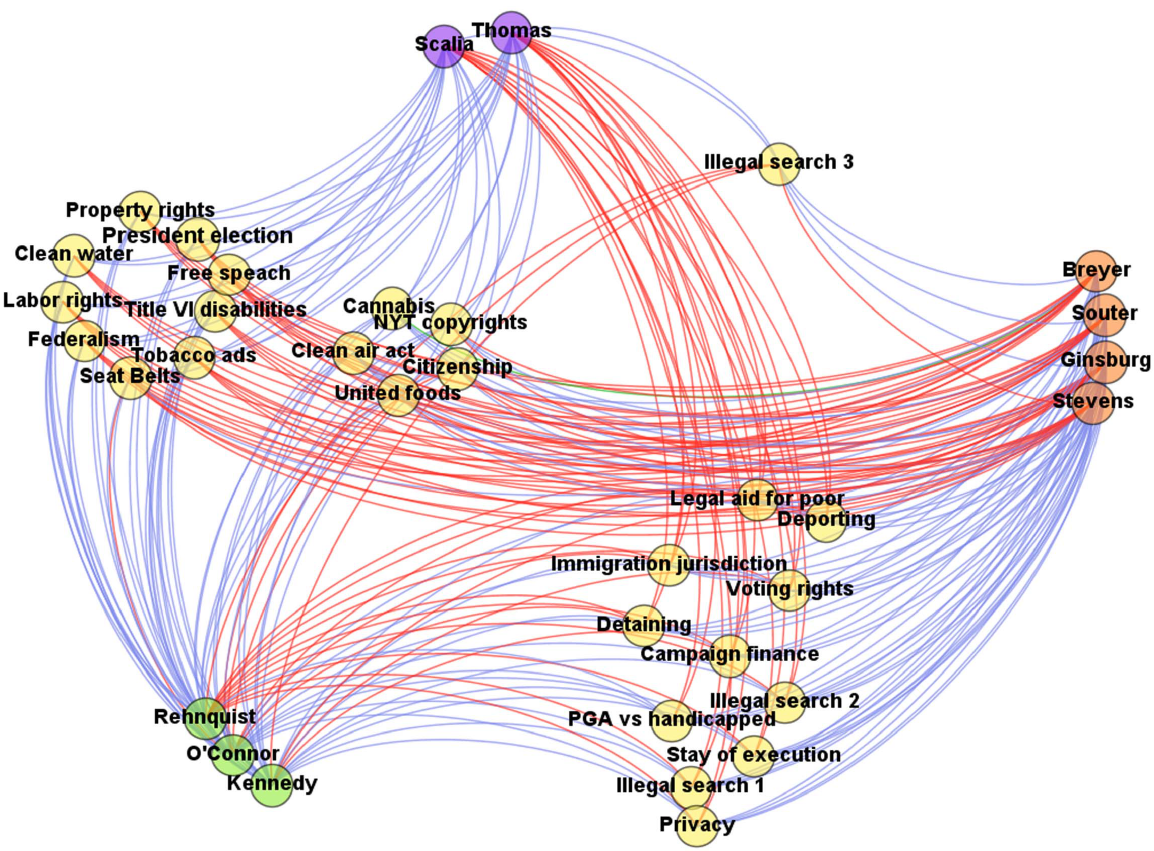
Figure 3. Justice sentences network. This figure depicts the bipartite signed network of the US Supreme Court Justice votes upon 26 different issues. The blue edges correspond to votes in the majority ( + 1), the red edges correspond to votes in the minority ( 2 1) and the unique green edge correspond to a case of abstention (0). Furthermore, the nodes are classified as follow: yellow for the 26 issues, violet for Cluster 1 , orange for Cluster 2 and green for Cluster 3 . The network has been built so as to capture the sharpness of the clusters partitioning. In particular, an higher cohesiveness among the judges within the first and second clusters with respect to those ones in the third cluster can be ascertained by the fact that a more coherent coloured pattern can be glimpsed from the beam of edges that originate from the first two clusters with respect to the last one, i.e. two different stacks can be distinguished, a red one and a blue one.